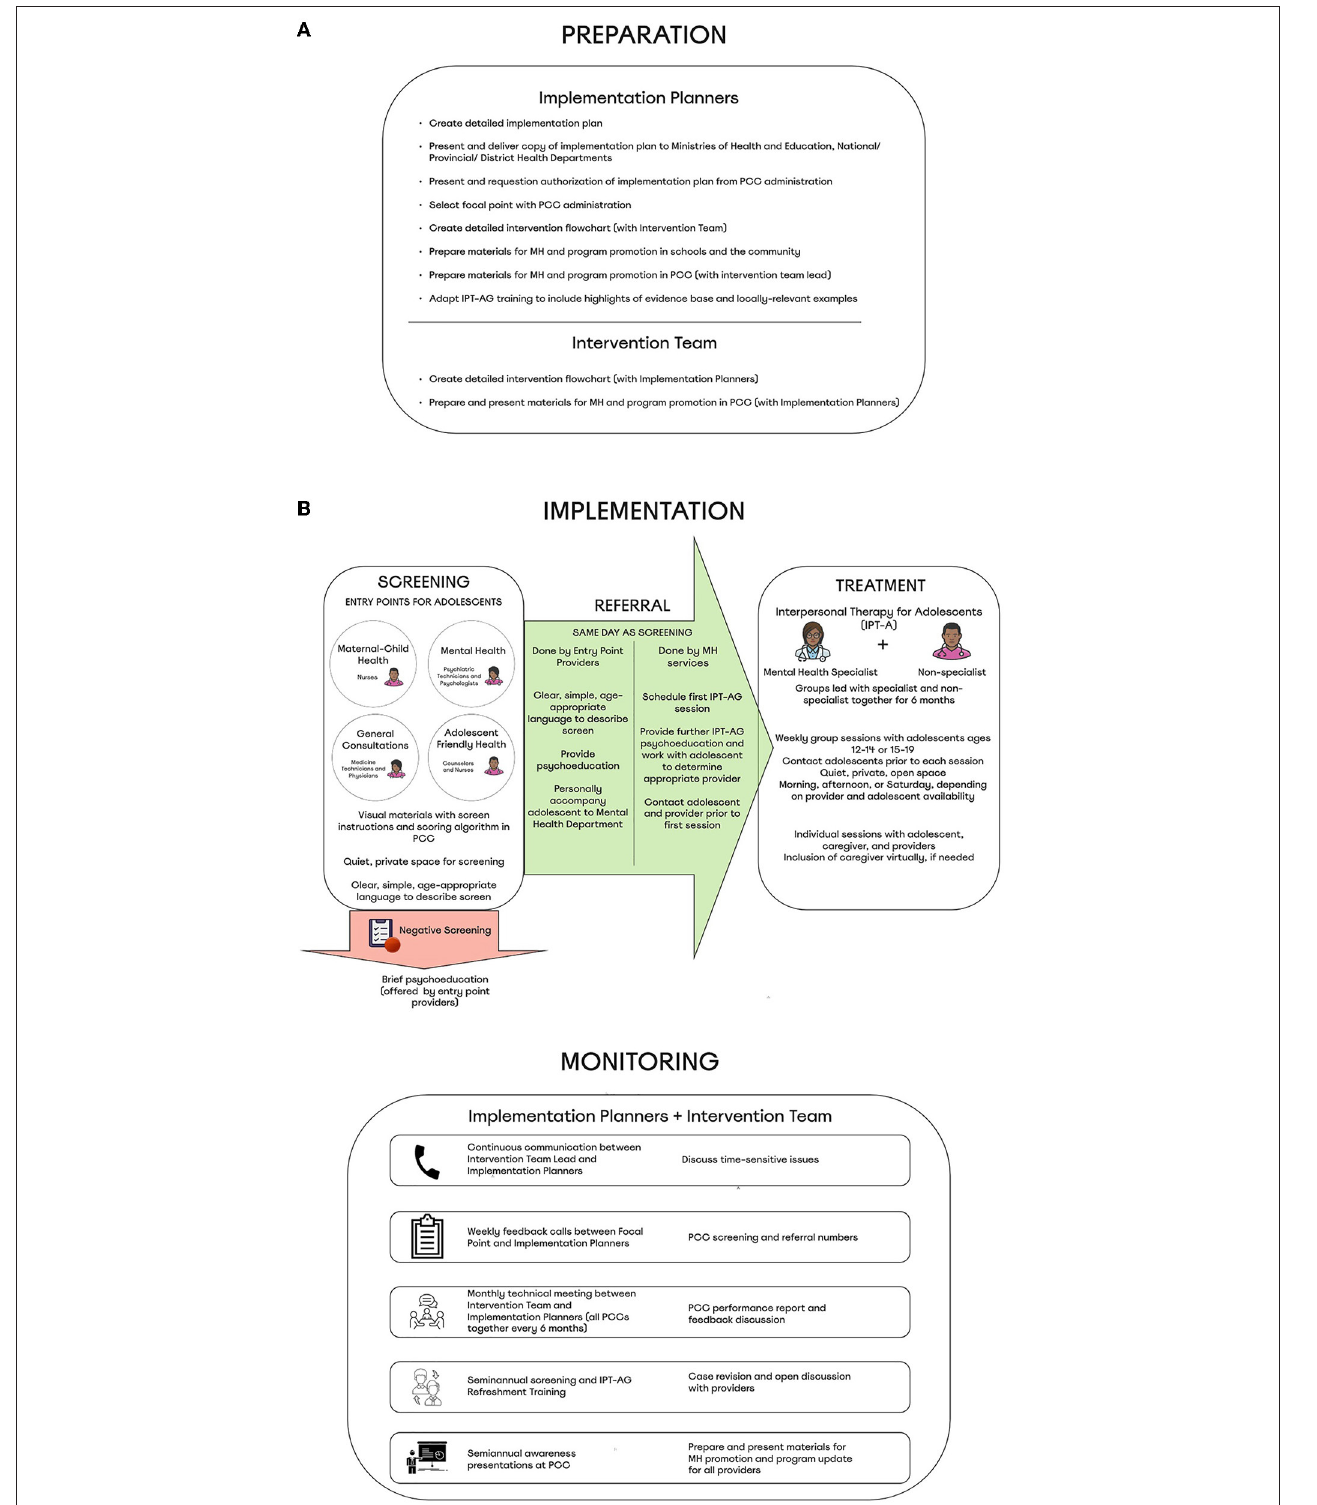
FIGURE 1 | (A,B) Implementation plan for adolescent depression services integrated within Mozambican primary care.